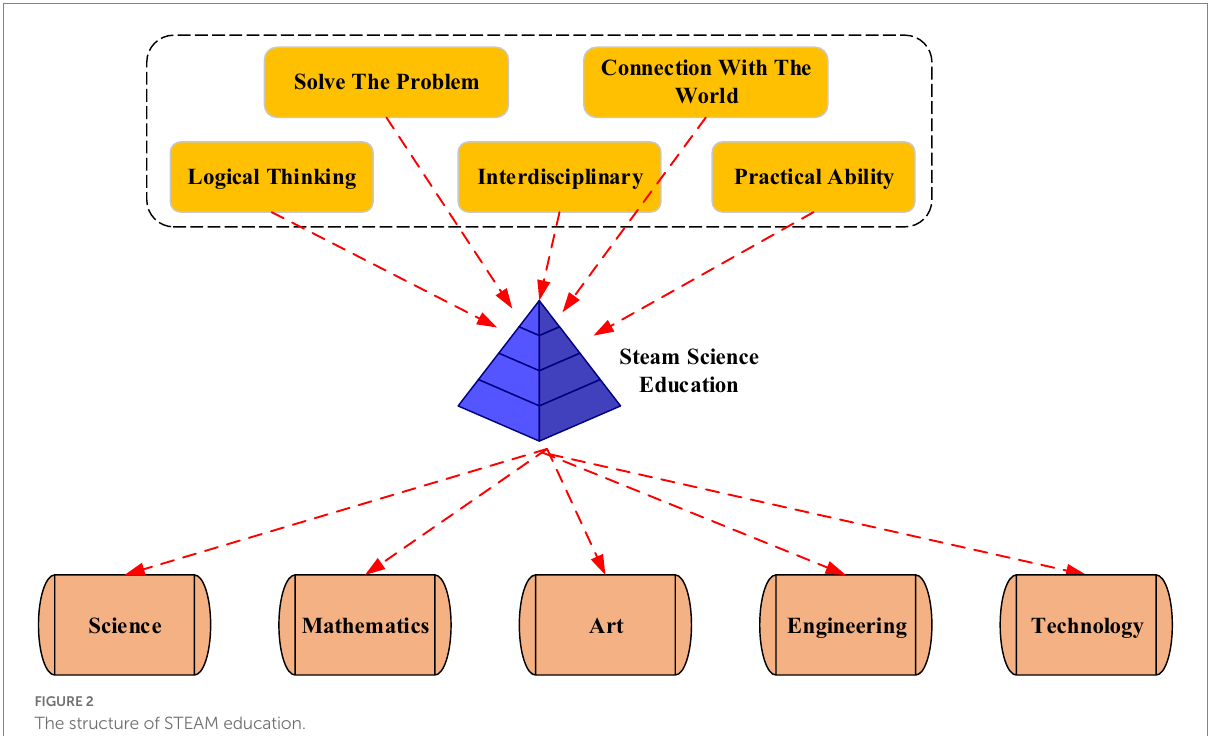
FIGURE 2 The structure of STEAM